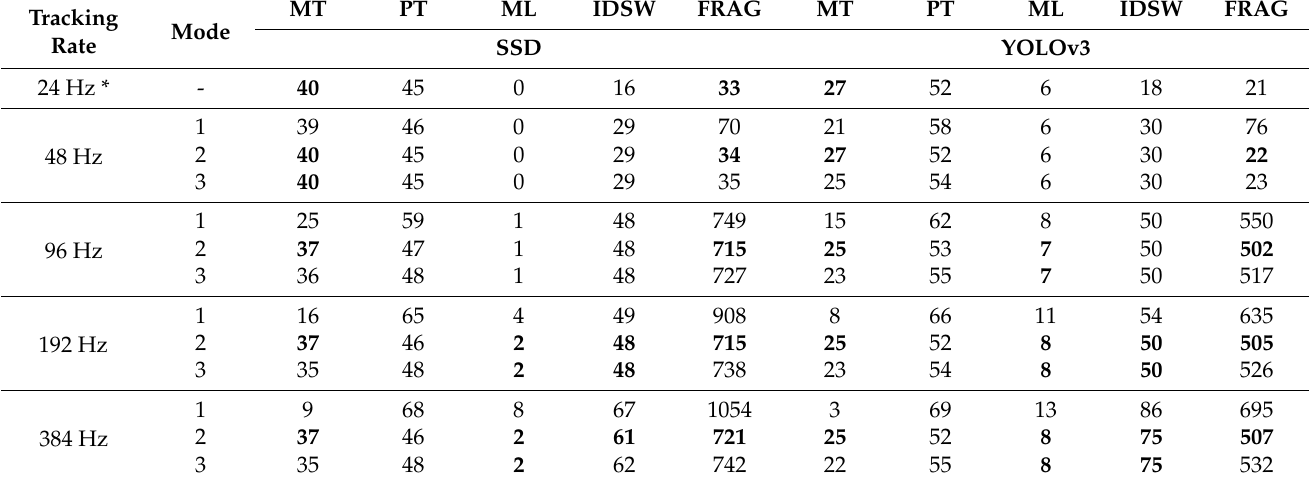
Table 3. Hybrid object detection and tracking results using a subset of CLEAR MOT metrics for different tracking configurations and temporal resolutions. The selected metrics provide extra insight into the behavior and the quality of each tracking configuration. Mode 2 (cid:48) s tracking configuration consistently outperformed the others in all metrics, deteriorating slightly with increasing temporal resolutions. The best metric value at each rate is in